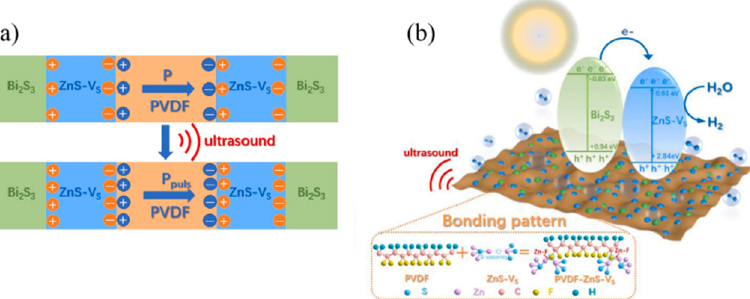
Figure 19. ( a ) Polarization schematic diagram of PVDF under ultrasonic conditions. ( b ) Schematic diagram of the photocatalytic mechanism of ZnS-VS/Bi 2 S 3 -PVDF under visible light irradiation (Reprinted/adapted with permission from Ref. [181]. Copyright 2022, copyright Elsevier).